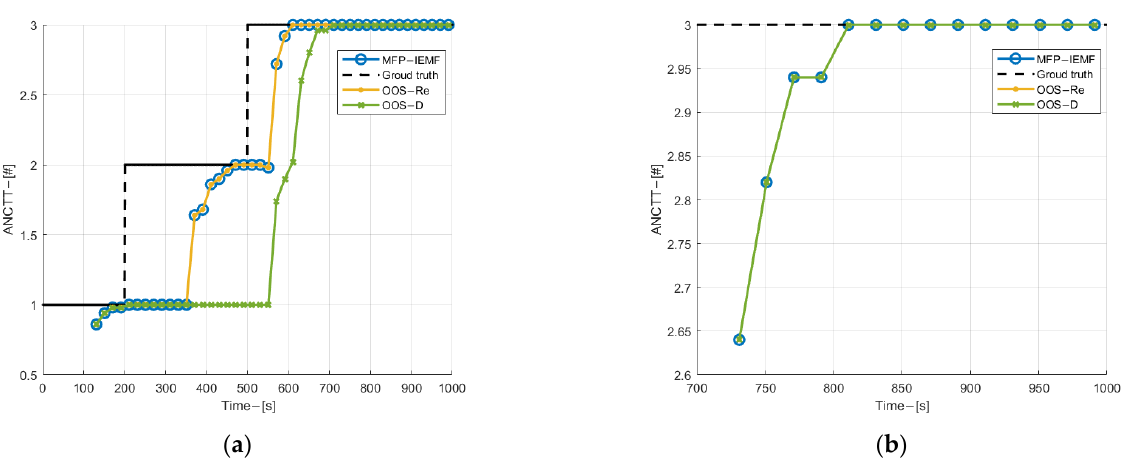
Figure 12. ( a ) ANCTTs with 5 lags; ( b ) ANCTTs with 35 lags.